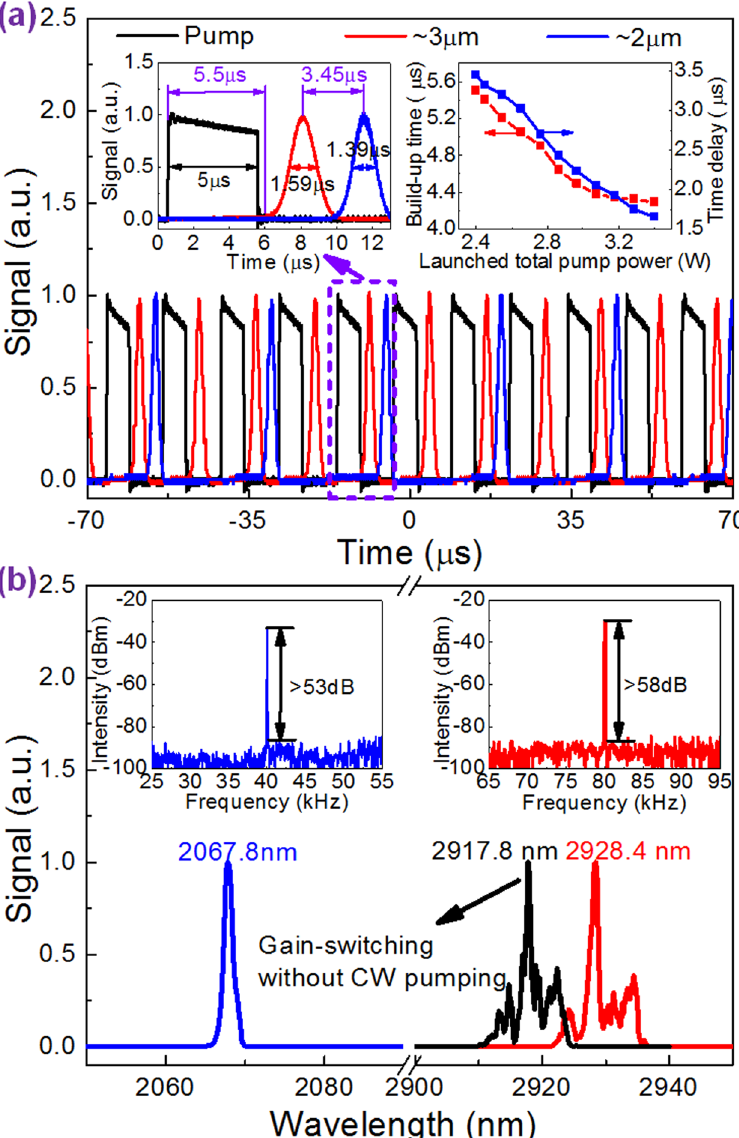
Figure 1. The output characteristics of “2-1” state. ( a ) Pulse trains and single pulse waveforms (left inset) at the LTPP of 2.4 W (LCWPP: 1.94 W, LPPP: 0.46 W), and build-up time and time delay versus the LTPP (right inset); ( b ) Optical and RF (insets) spectra at the LTPP of 3.4 W (LCWPP: 1.94 W, LPPP: 1.46 W). Note: the black optical spectrum was recorded at the LPPP of 1.8 W when switching off CW pump